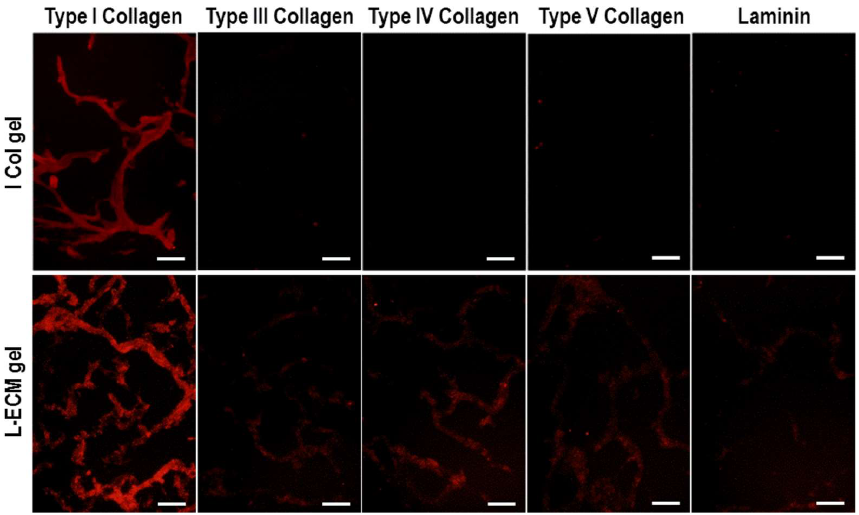
Figure 7. Fluorescent immunostaining images of I Col and L-ECM gel (scale bar = 50 μm).